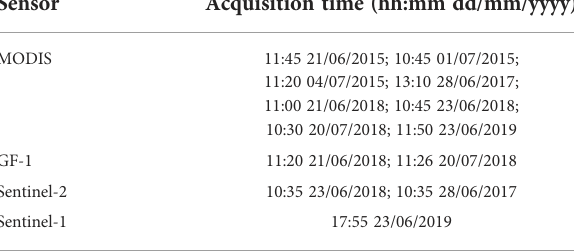
TABLE 1 Acquisition time of the satellite